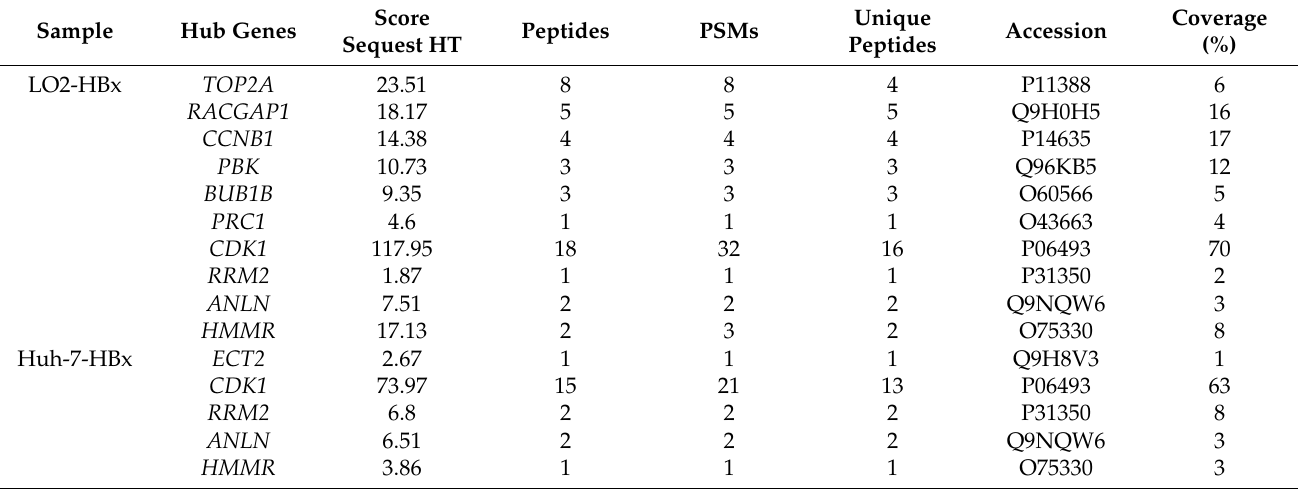
Table 1. The list of identified HBx-interacting proteins from